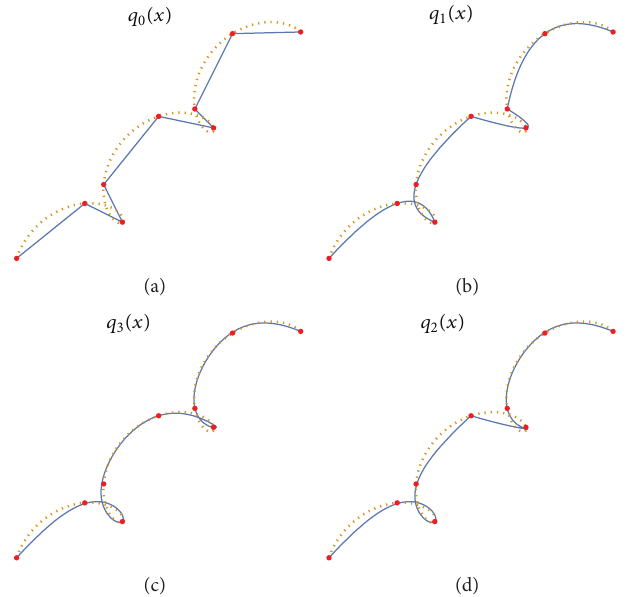
Figure 6: Smoothened piecewise linear interpolations 𝑞 𝑗 (𝑡) , 𝑗 = 0 , 1 , 2 , 3, for the parametric function 𝑟(𝑡) with 𝑁 = 2 3 . The dotted curve indicates the original graph of 𝑟(𝑡) .